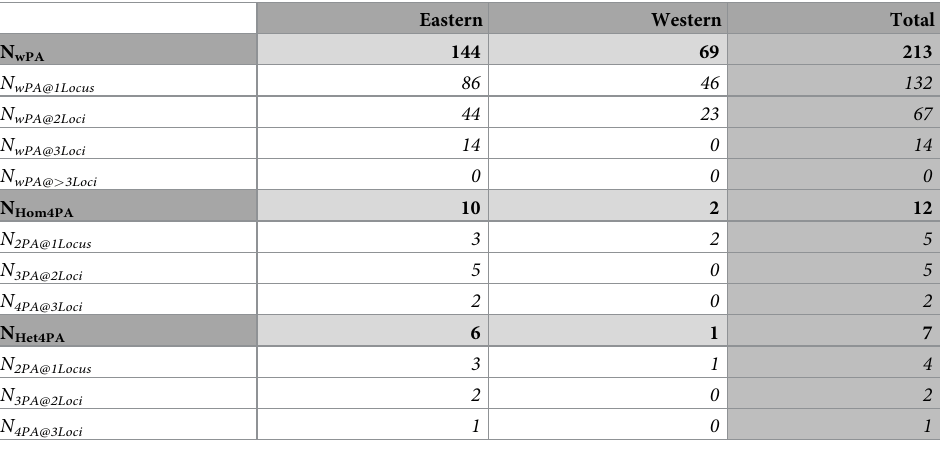
Table 5. Number of individuals with private alleles (PA). N #PA@#Loci is the number of private alleles at the given number of loci. Totals are given for the total number of individuals with any PA (N wPA ), number of individuals homo- zygous for a PA (N Hom4PA ), i.e. two of the same PA at the same locus for one or more loci, and number of individuals heterozygous for a PA (N Hom4PA ), i.e. two different PA at the same locus for one or more loci. Eastern Western Total N wPA 144 69 213 N wPA@1Locus 86 46 132 N wPA@2Loci 44 23 67 N wPA@3Loci 14 0 14 N wPA@ > 3Loci 0 0 0 N Hom4PA 10 2 12 N 2PA@1Locus 3 2 5 N 3PA@2Loci 5 0 5 N 4PA@3Loci 2 0 2 N Het4PA 6 1 7 N 2PA@1Locus 3 1 4 N 3PA@2Loci 2 0 2 N 4PA@3Loci